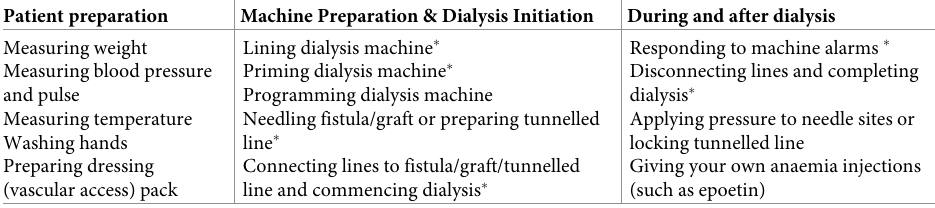
Table 1. Primary endpoint–five or more dialysis related tasks. Patient